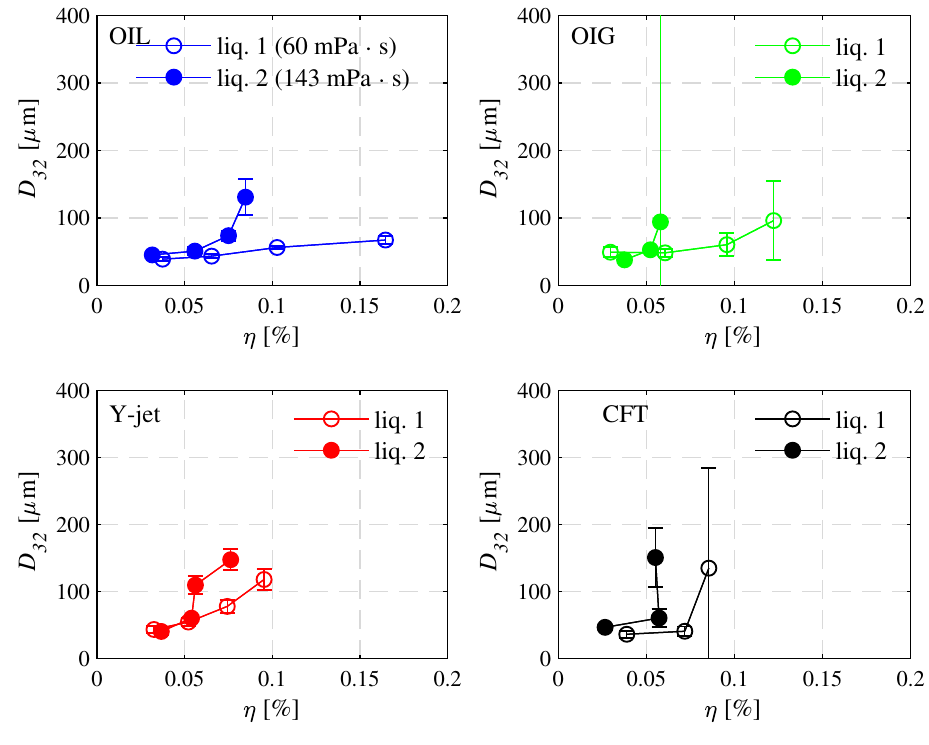
Figure 13. Atomization efficiency and drop